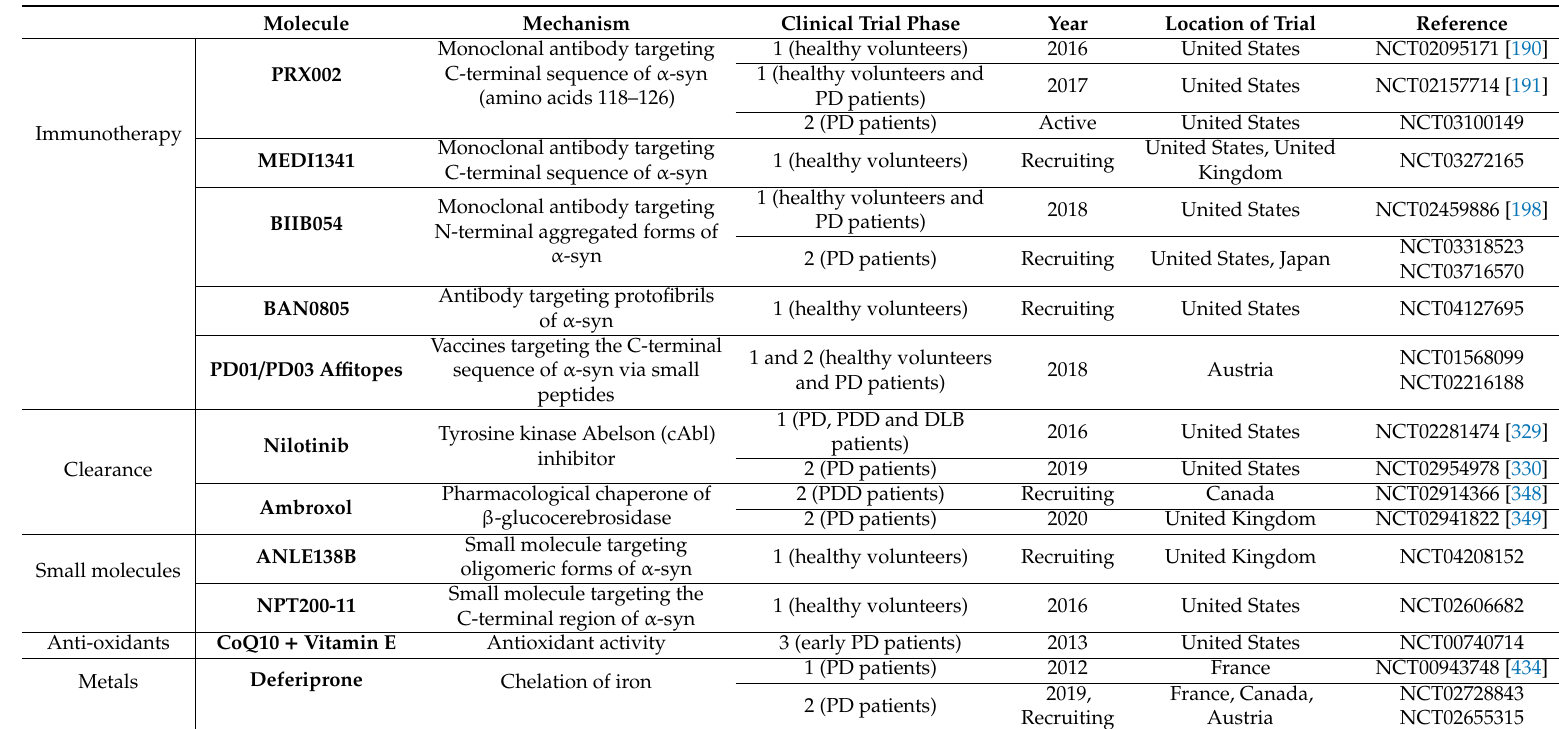
Table 1. Drug-based clinical trials targeting α -synuclein accumulation directly or